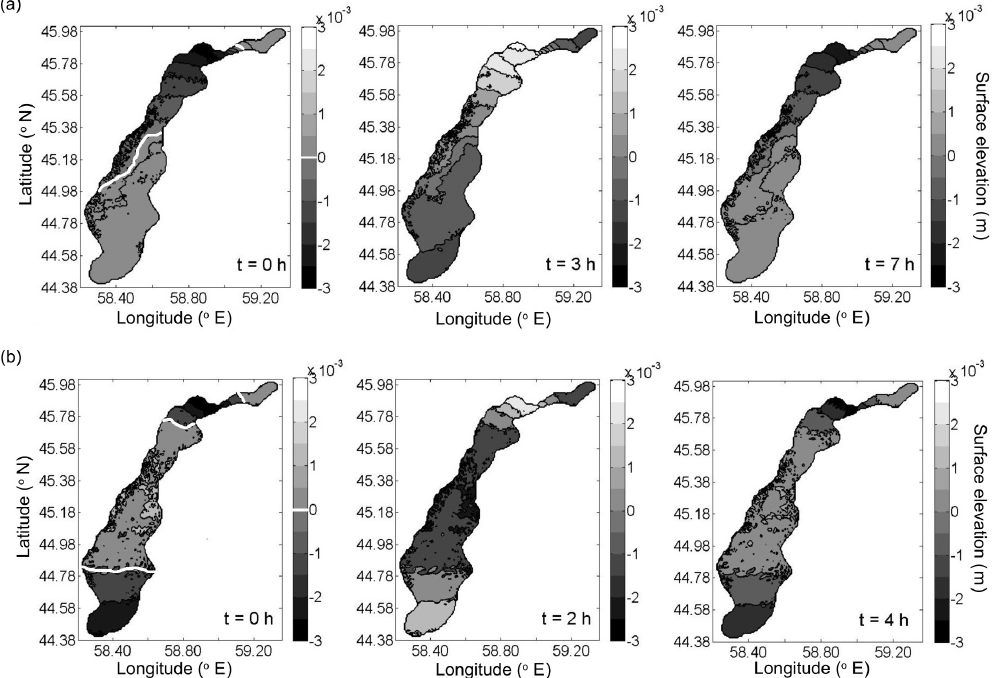
Figure 8. Band-pass-filtered surface elevations at three different times covering one oscillation of the internal seiches of (a) 7h and (b) 4h in